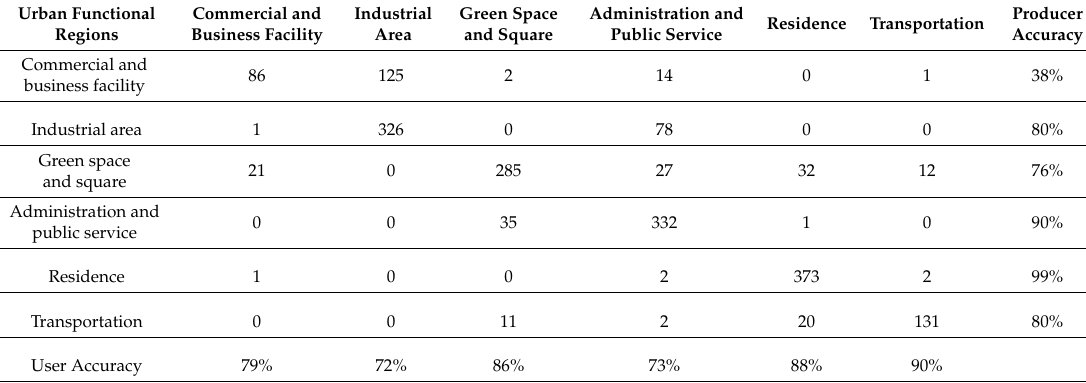
Table 7. The confusion matrix of the urban functional region